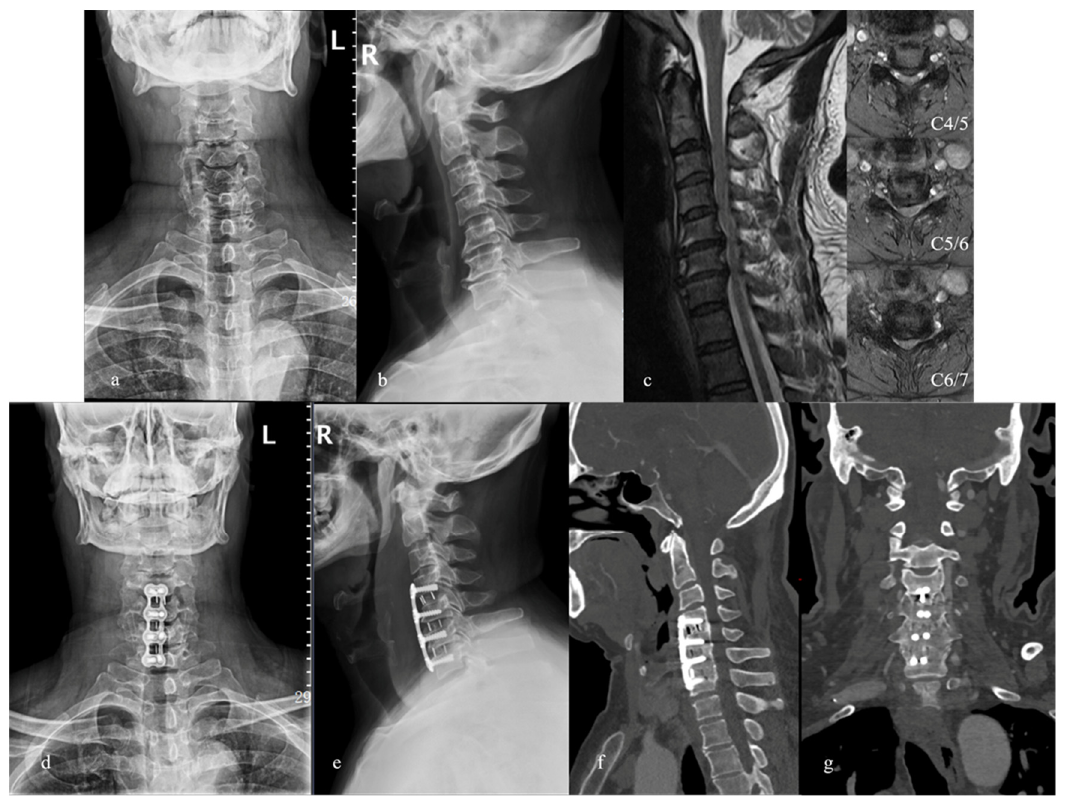
Figure 2. A 53-year-old male with upper limb numbness and clumsiness as well as walking disturbance for 1 year. ( a , b ) Preoperative X-ray films; ( c ) preoperative MRI showing spinal canal stenosis with C4-C7 disc herniation compressing the spinal cord; ( d , e ) postoperative X-ray films showing C4-C7 ACDF with plate-cage system; ( f , g ) CT scans at 3-year follow-up showing good implant position and bone fusion.